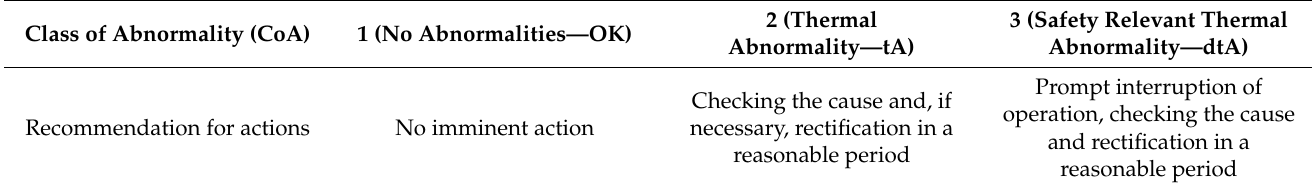
Table 7. Allocation in classes of